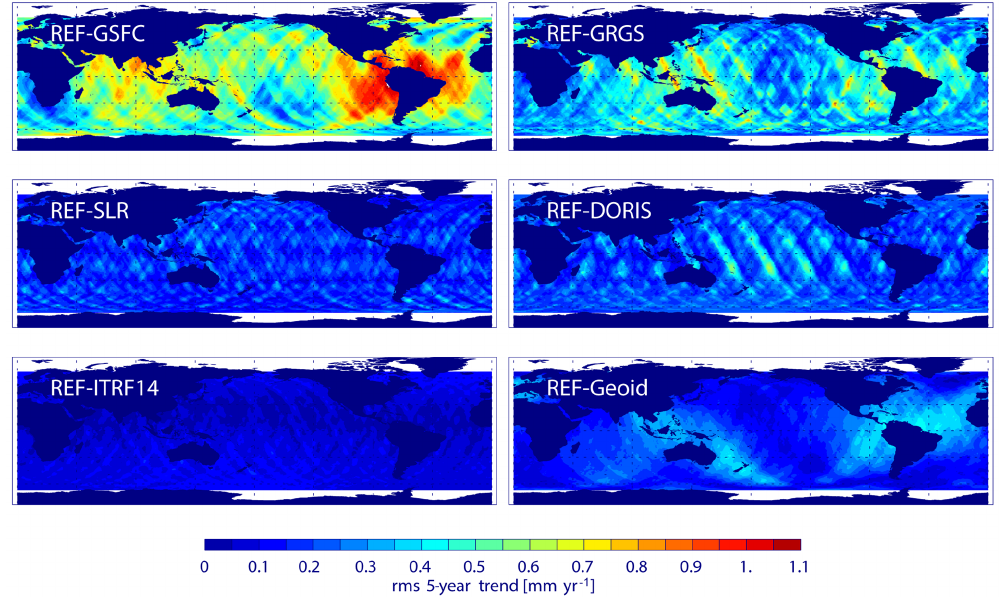
Figure 6. The rms of 5-year running trend differences of the radial orbit components for REF minus GSFC, REF minus GRGS, REF minus SLR, REF minus DORIS, REF minus ITRF14, and REF minus Geoid for the period April 1993–June 2004. The global mean rms of the differences over the ocean is given in Table 4.